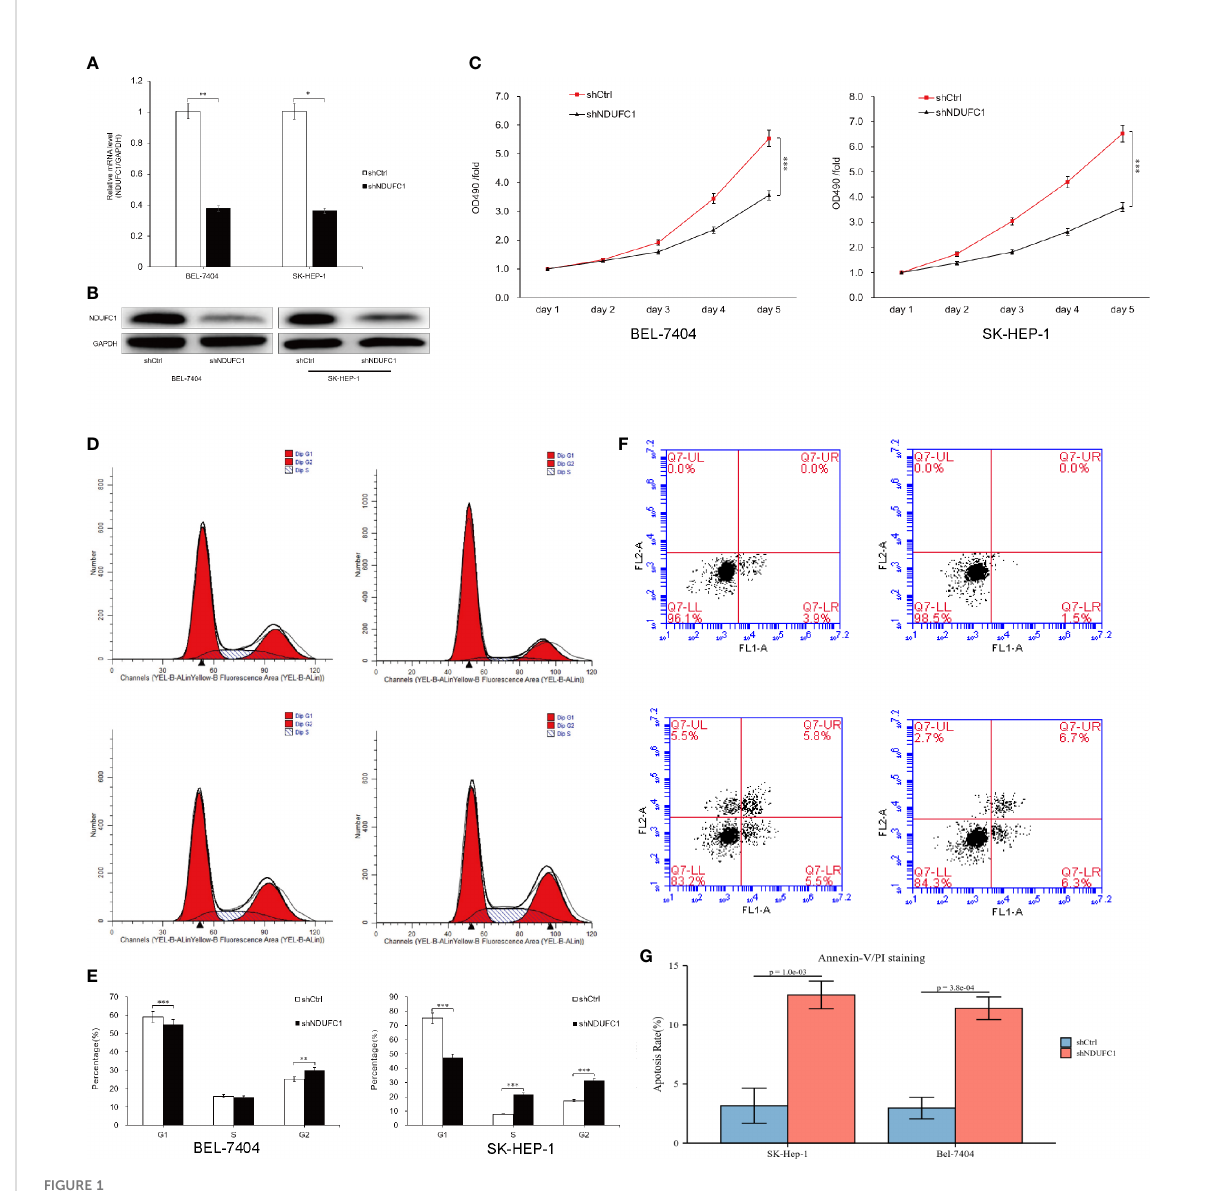
FIGURE 1 Silencing of NDUFC1 inhibited HCC cell growth. (A, B) qRT-PCR and Western blot results showed that NDUFC1 was stably downregulated in BEL-7404 and SK-HEP-1 cells infected with Lv-shNDUFC1. GAPDH was used as control gene. (C) MTT assay was used to con fi rm that silencing of NDUFC1 inhibits cell proliferation of BEL-7404 cells and SK-HEP-1 cells. (D, E) Flow cytometric analysis showed that silencing of NDUFC1 retarded the cell cycle progression of BEL-7404 cells and SK-HEP-1 cells. (F, G) Flow cytometric analysis was used to con fi rm that silencing of NDUFC1 increased apoptosis of BEL-7404 and SK-HEP-1 cells. *P<0.05; **P<0.01;